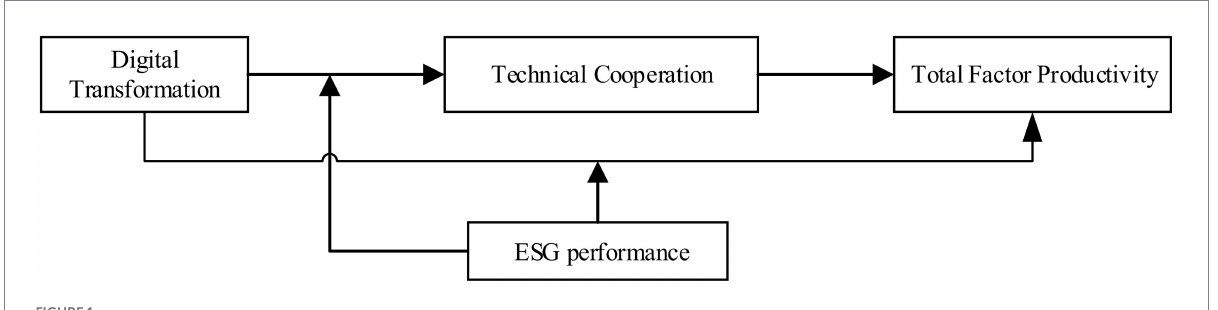
FIGURE 1 Theoretical